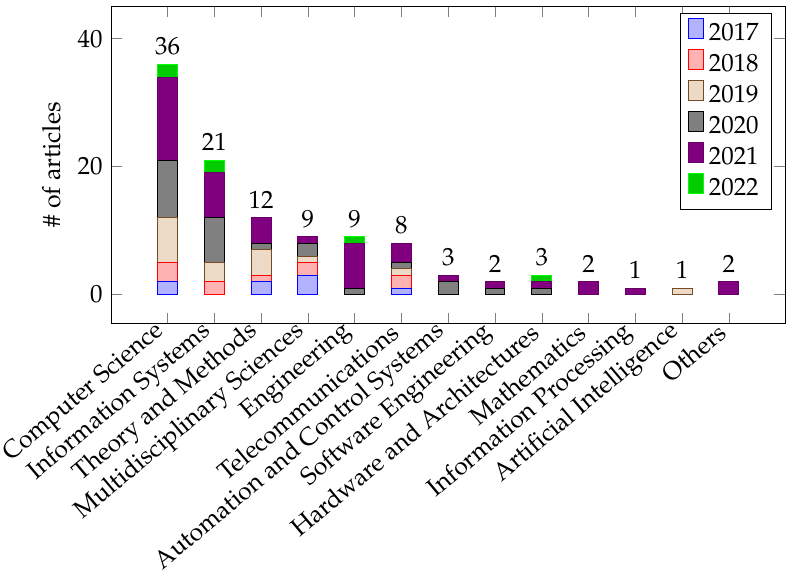
Figure 5. Subject domain of the publication sources of the included articles (note: one publication may be attributable to multiple subjects, and one source may have more than one subject